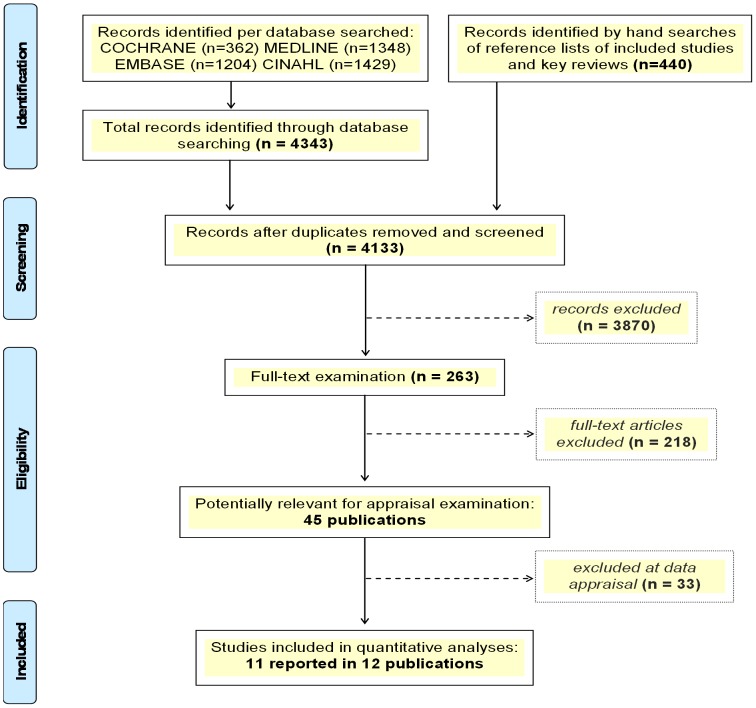
PRISMA Flow diagram – study selection process.